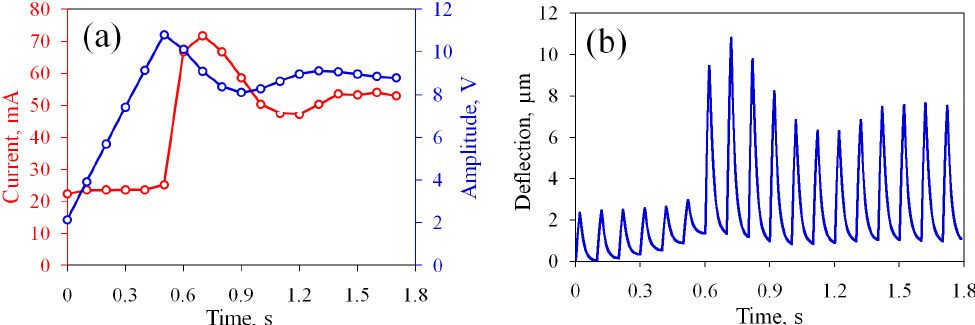
Figure 4. Operation of the actuator in the current stabilization regime during the first 18 cycles: ( a ) the average current and amplitude of the SP pulses; ( b ) the deflection of the membrane. The PI coefficient is K = 1.5 × 10 8